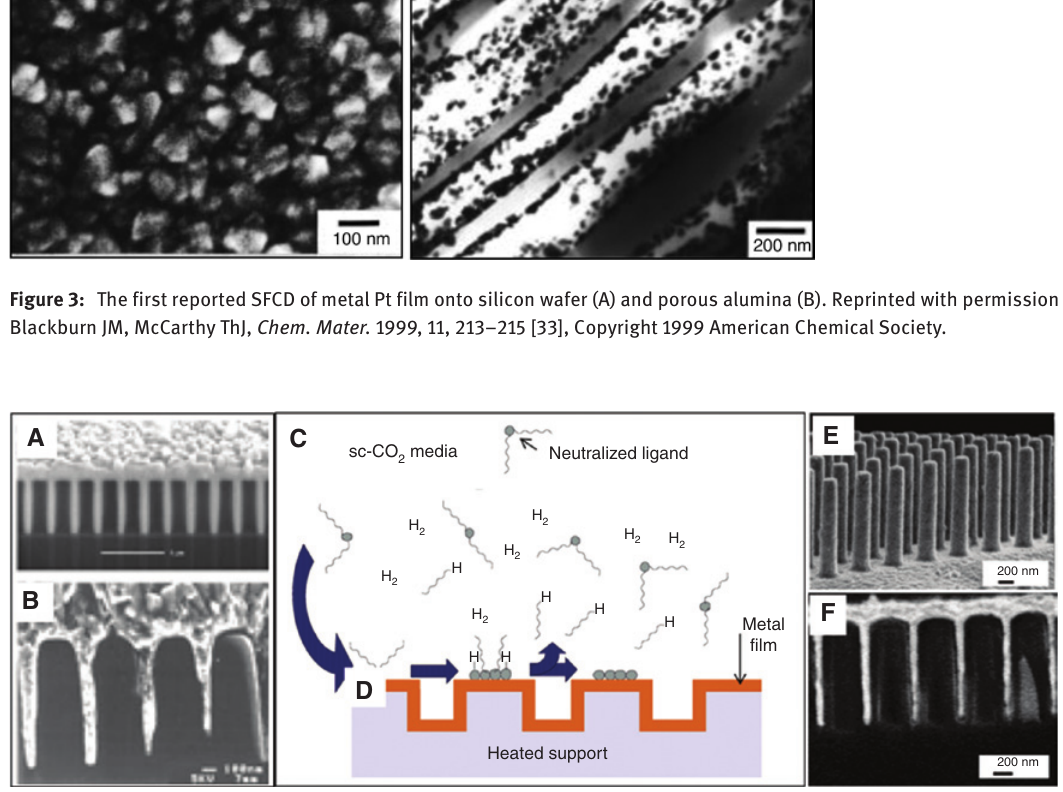
(Figure 3B). An effective metallization of a porous solid can be provided by separately controlling the transport (via a solution) and deposition mechanisms (via a chemi- cal reducing agent).